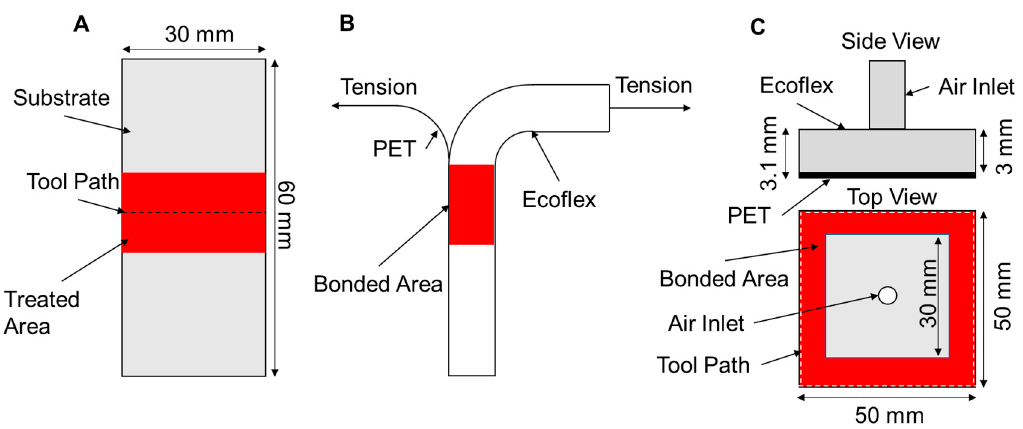
Figure 3. ( A ) Sample design to test bond resolution and width. ( B ) 180° peel test. ( C ) Sample design for bond pressure testing.